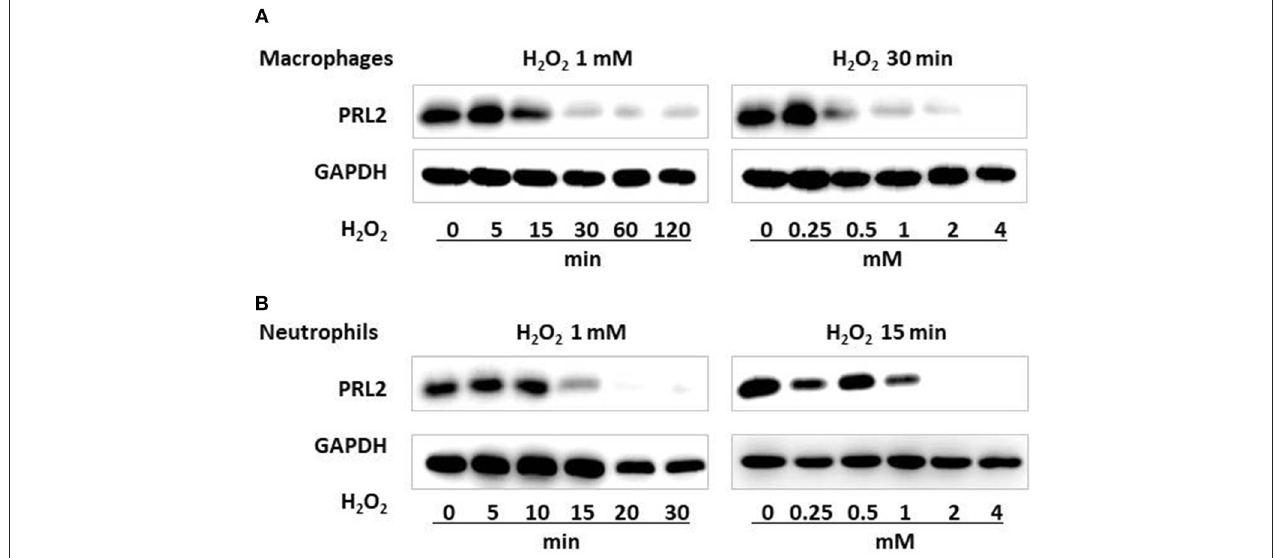
FIGURE 2 | PRL2 is susceptible to oxidative stress. (A) Wild-type bone marrow-derived macrophages were treated with 1mM H 2 O 2 for the indicated times, or with the indicated concentrations of H 2 O 2 for 30min. Cell lysates were subjected to SDS-PAGE followed by immunoblot analysis using the indicated antibodies. (B) Mouse bone marrow neutrophils were treated with 1mM H 2 O 2 for the indicated times, or with the indicated concentrations of H 2 O 2 for 15min. Cell lysates were subjected to SDS-PAGE followed by immunoblot analysis using the indicated antibodies. Data are representative of three independent experiments.